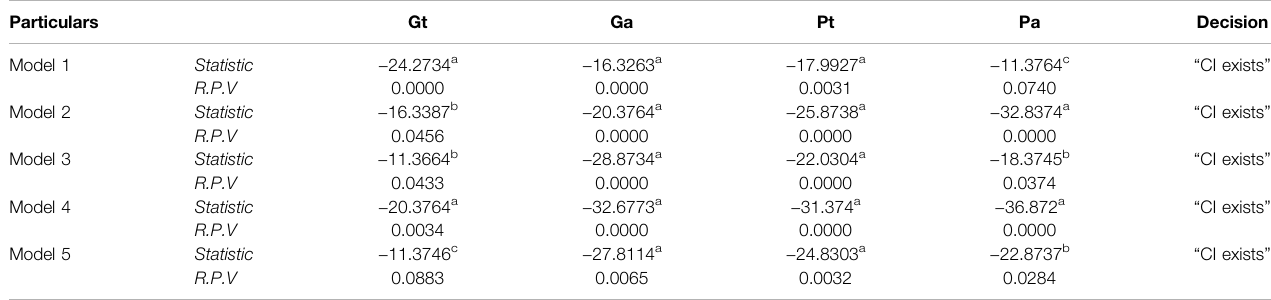
TABLE 6 | Westerlund co-integration (CI) test.